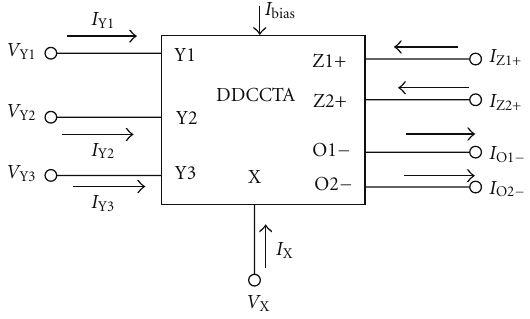
Figure 1: Circuit symbol of the proposed